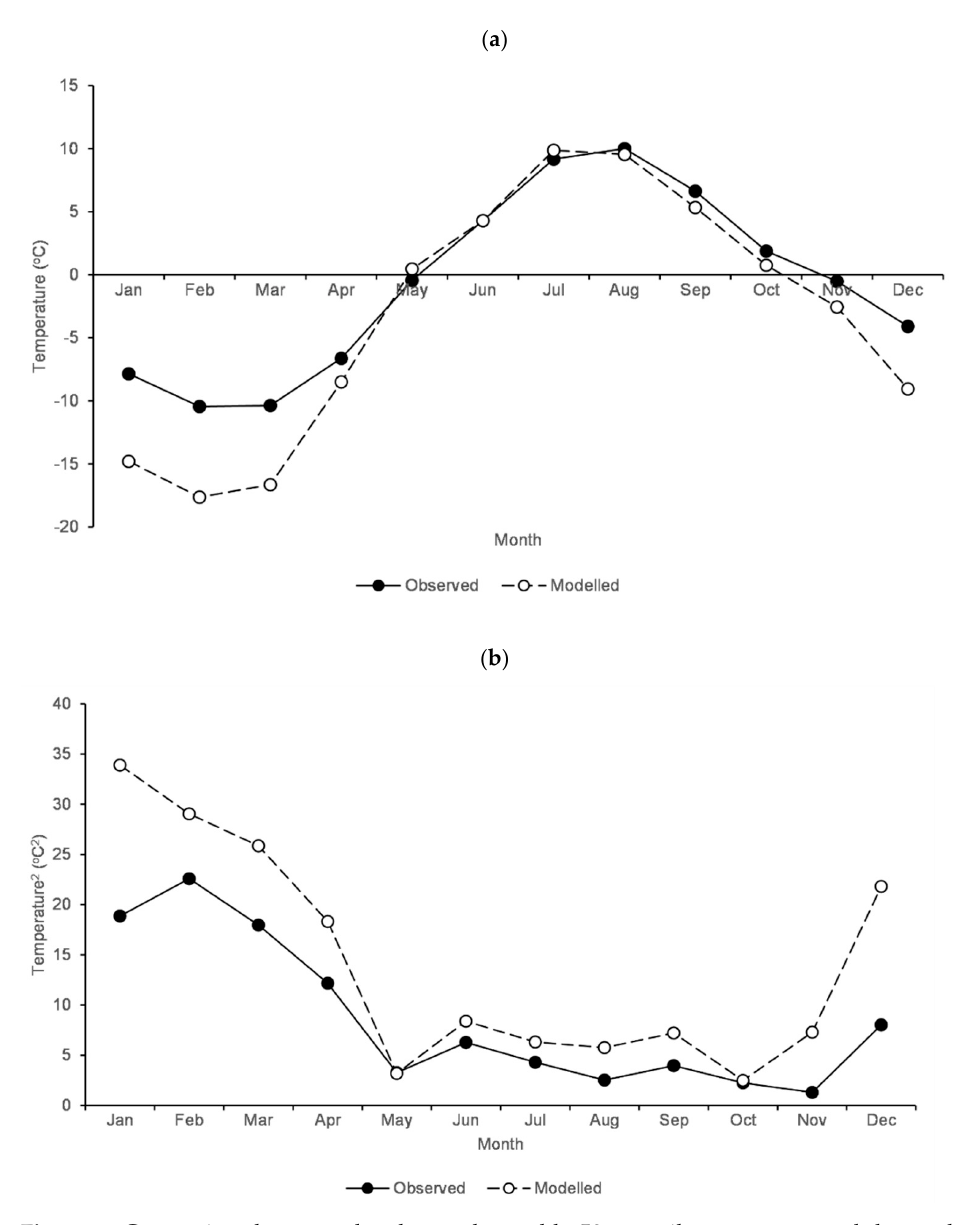
Figure 6. Comparison between the observed monthly 50 cm soil temperature and the predicted values from the CanESM2 and NCEP models for: ( a ) mean; ( b ) variance.